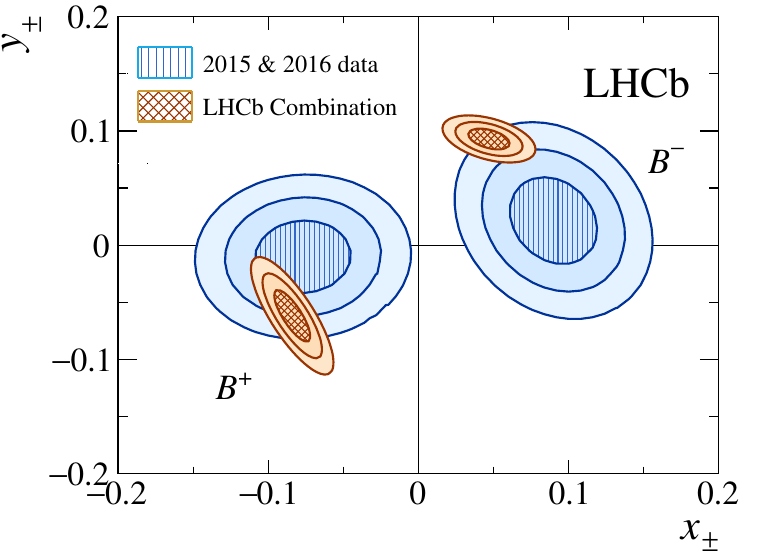
Figure 10 . Two-dimensional 68.3 %, 95.5 % and 99.7 % con(cid:12)dence regions for ( x (cid:6) ; y (cid:6) ) obtained in this measurement, as well as for the LHCb combination in ref. [2], taking statistical and systematic uncertainties, as well as their correlations, into account.